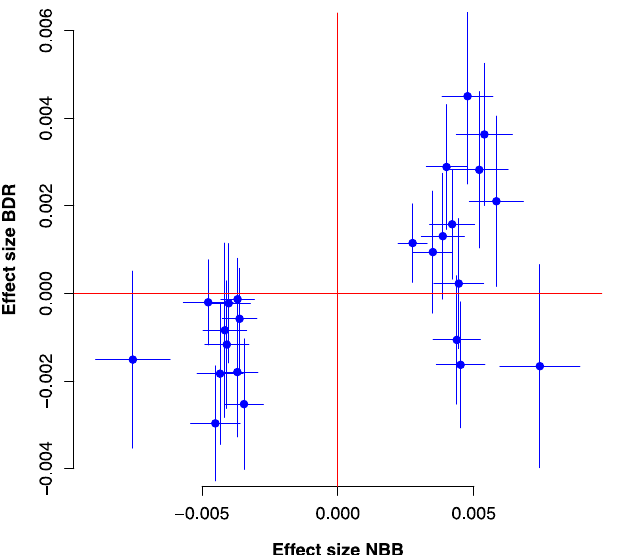
Fig. 3 | Adjusted methylation values for the signi fi cant probe cg07107199 across Braak stages. The fi gure shows individual methylation values in the dis- covery dataset ( n =322 biologically independent samples), adjusted for covariates as described in the Methods section. A regression line is shown indicating increasing methylation levels with higher Braak α -synuclein stage (Intercept= 0.578, coef fi